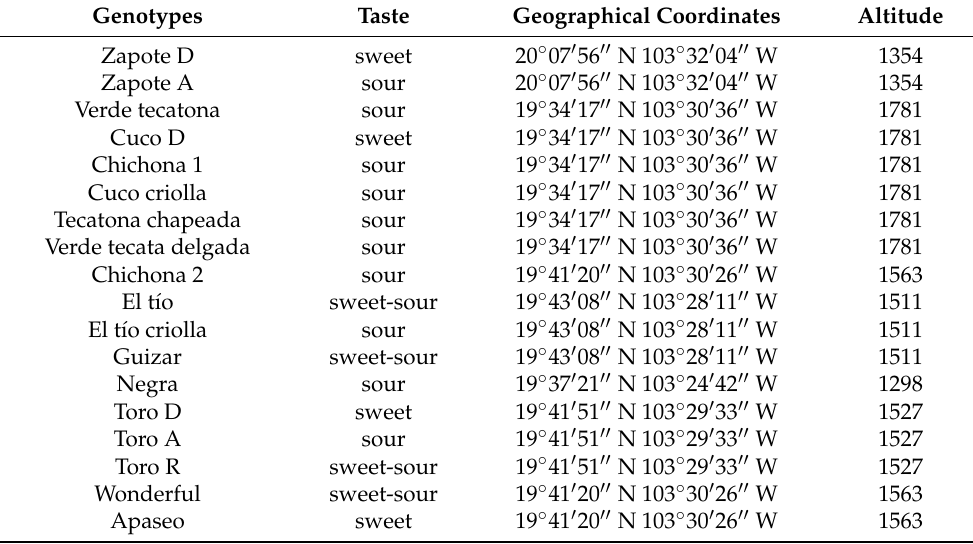
Table 1. Punica granatum genotypes collected from southern Jalisco, Mexico, used in this study.